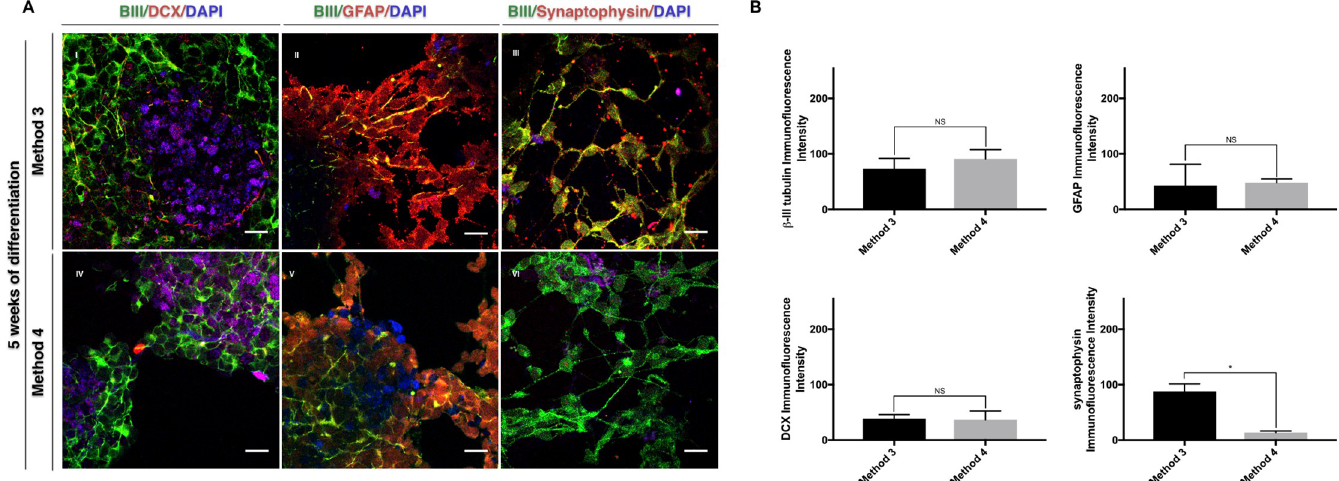
Fig 4. Effect of exosomes from pluripotent cells on the differentiation of transdifferentiation of MSCs to INSCs. Panel A shows the immunostaining of the NSCs- MSCs differentiated within four weeks, which express neurons and glial markers DCX, GFAP, β III-tubulin, and synaptophysin method 3 and method 4. Panel B shows the difference between the immunofluorescence intensities of the immunostaining in panel A. All nuclei were counterstained with DAPI. The scale bar is 25 μ m. � P < 0.05.